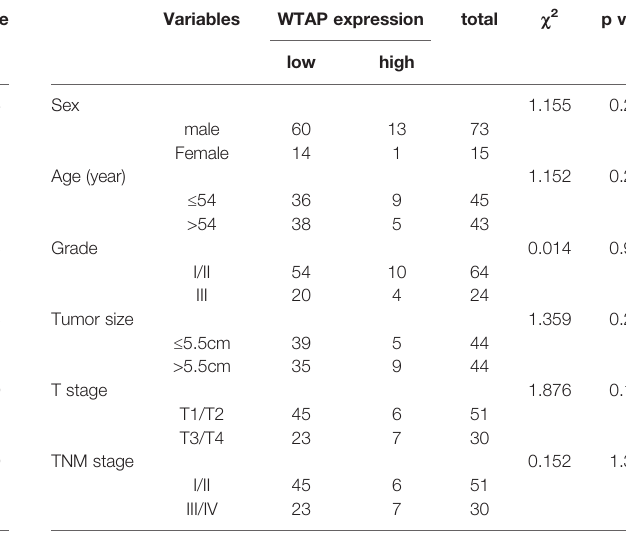
Table 1 . We found a signi fi cant association between low cytoplasmic WTAP expression and tumor grade ( P = 0.04).